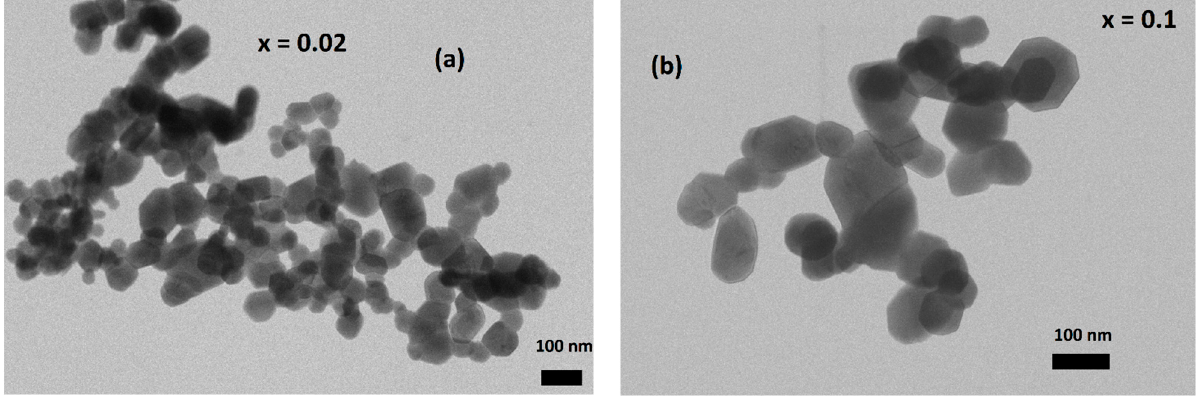
Figure 3. Selected optical microscope pictures for Pr 0.7 Sr 0.3-x Ca x MnO 3 bulk samples ( a ) for x = 0.02, ( b ) x = 0.05.